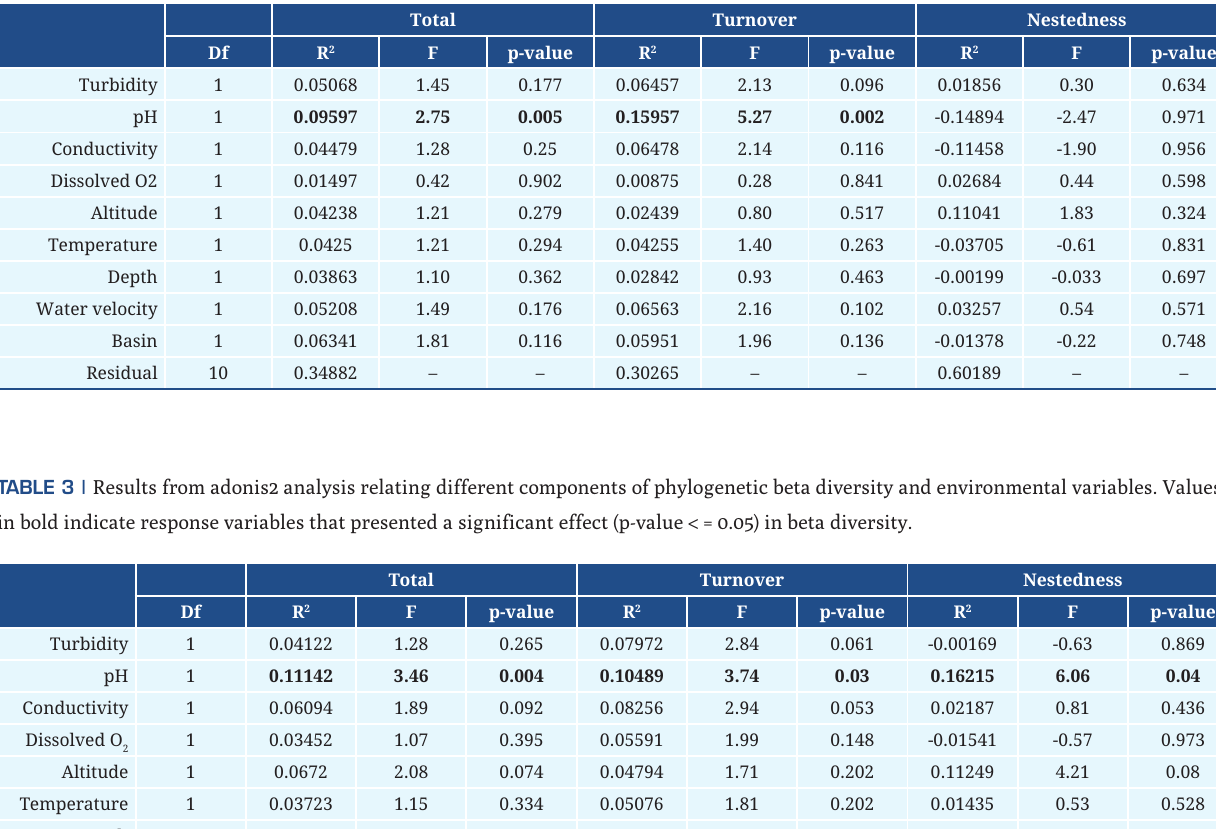
TABLE 2 | Results from adonis2 analysis relating different components of taxonomic beta diversity and environmental variables. Values in